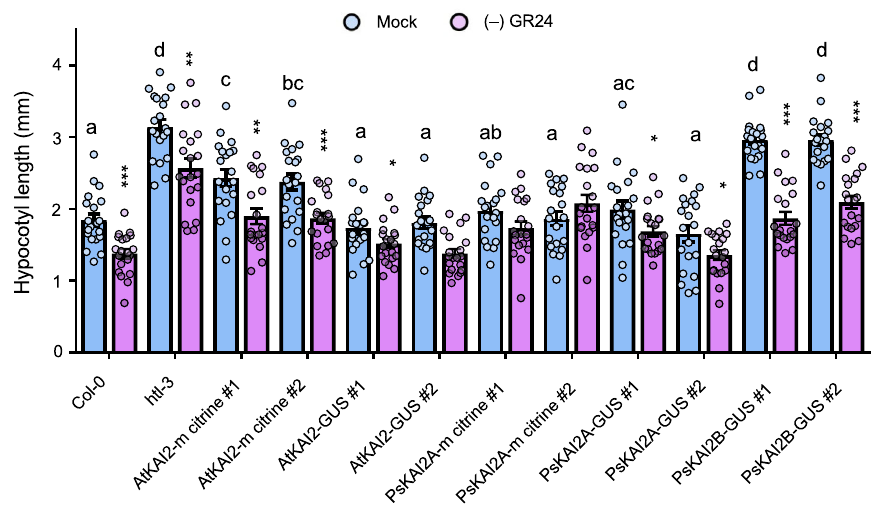
Fig. 3 Arabidopsis hypocotyl elongation complementation assays with PsKAI2s. Hypocotyl length of 7-day-old seedlings grown under low light at 21 °C. Data are means ± SE ( n = 20 – 24; 2 plates of 10-12 seedlings per plate). Light blue bars: Mock (DMSO), lavender bars: ( – )-GR24 (1 µ M). Complementation assays using the AtKAI2 promoter to express AtKAI2 (control) or PsKAI2 genes in the htl-3 mutant background (Col-0 ecotype) as noted above the graph. Proteins were tagged with mCitrine or GUS protein. For DMSO controls, statistical differences were determined using a one-way ANOVA with a Tukey multiple comparison of means post-hoc test, statistical differences of p < 0.05 are represented by different letters. Means with asterisks indicate signi fi cant inhibition compared to mock-treated seedlings with *** corresponding to p ≤ 0.0001, ** corresponding to ≤ 0.001 and * to p ≤ 0.01, as measured by t